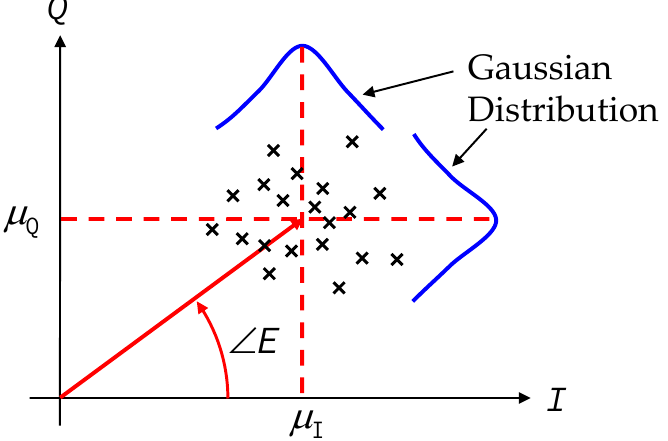
Figure 8. Mean IQ-value method for estimating the angle of incoming waves in a Rice propagation environment.